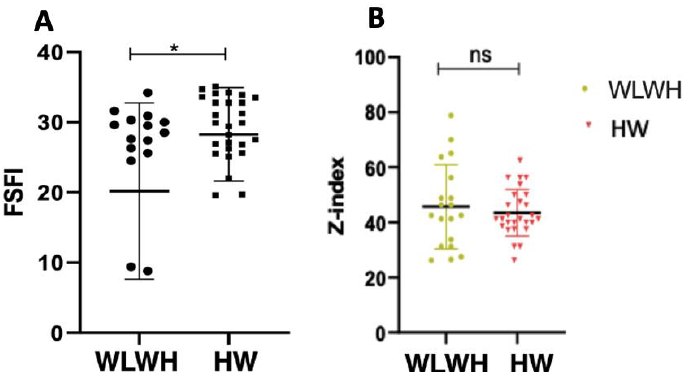
Figure 5. Sexual health and psychological well-being of the study population ( A ) Differences in overall FSFI scores in WLWH and HW. ( B ) Generalized anxiety disorder in WLWH and HW. Statistical significance ( p ) is reported in the graphics. * p < 0.05.